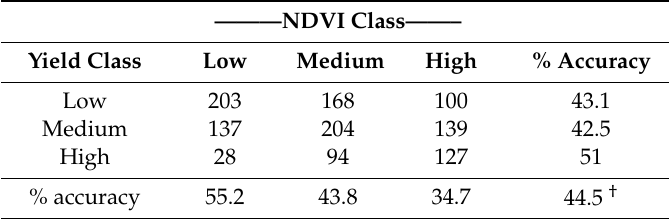
Table 3. Contingency table comparing grain yield classes to NDVI classes (k-means clustering) for all dates, site years and two irrigation conditions in this study merged